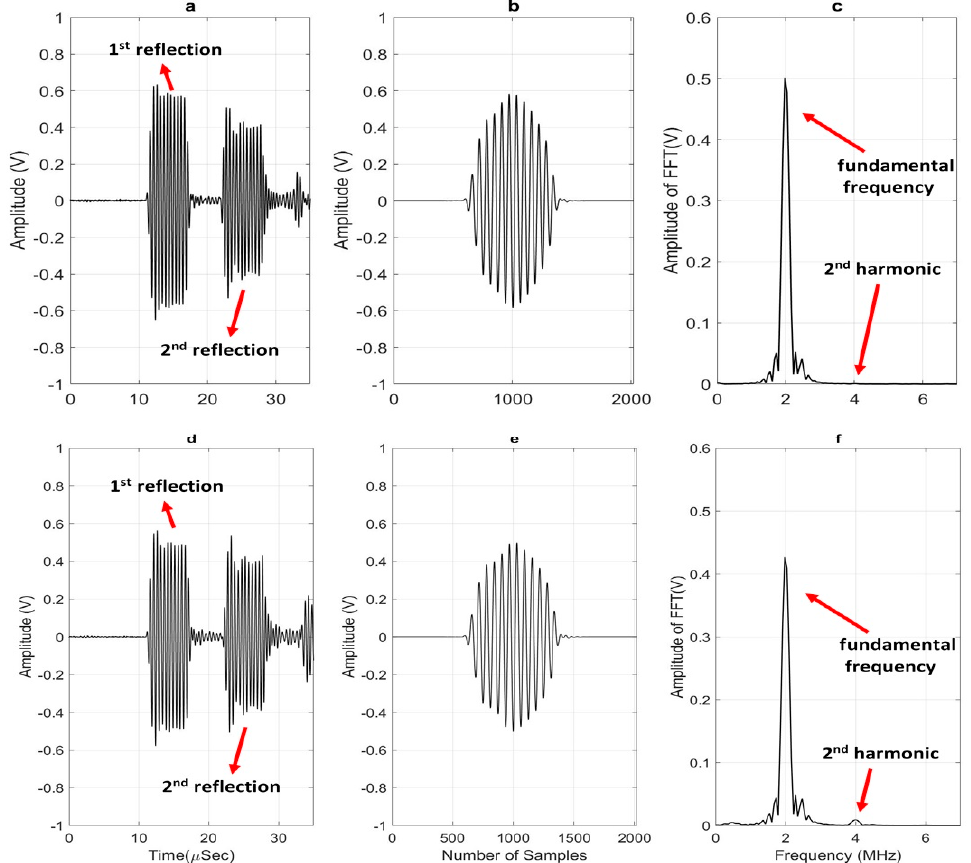
Figure 5. Signal processing of the reflected pulses from interface using a 140 V excitation with incident frequency 2 MHz: ( a – c ) solid-air contact (reference signal); ( d – f ) solid-solid contact at nominal contact pressure 4 MPa ; ( a , d ) time domain of generated, first and second reflected pulses; ( b , e ) Hanning window and zero pad result of the first reflected pulse; ( c , f ) Fast Fourier Transform (FFT) results of the first reflected pulse.